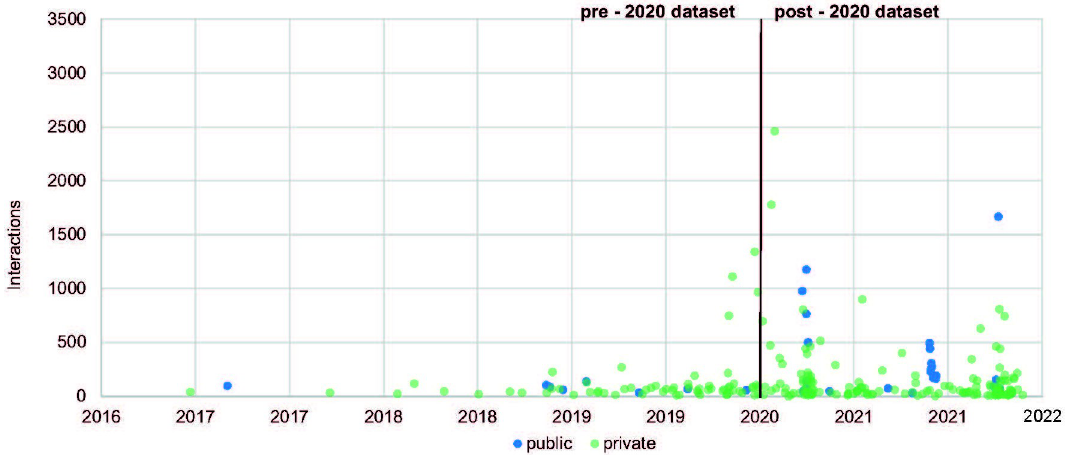
Fig 9. Occurrence of term ‘icon ’ in posts over time per actor group (by